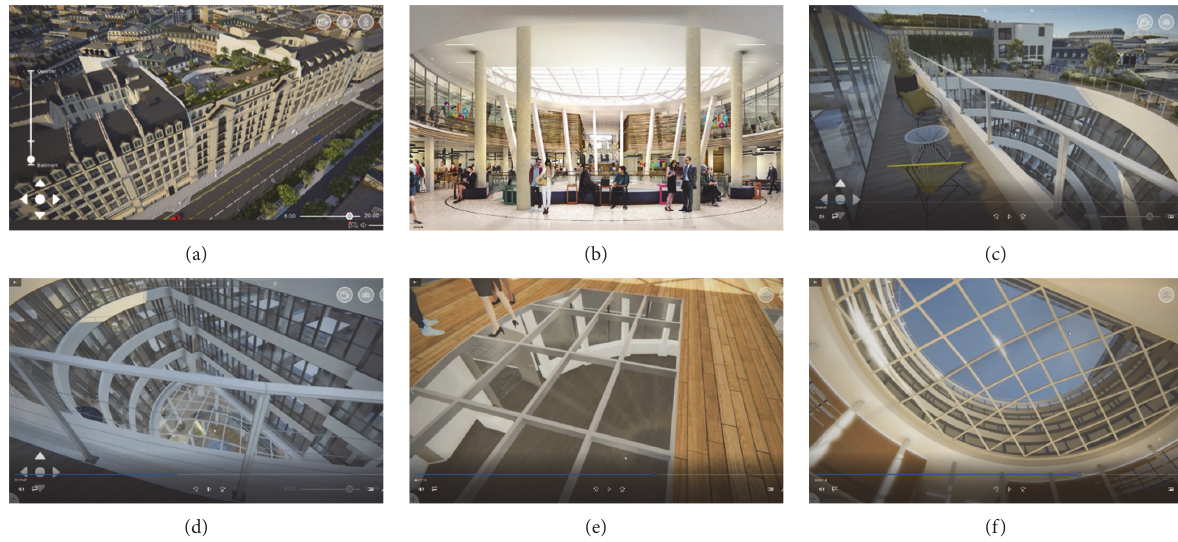
Figure 15: Selection of screenshot frames from the VR video clip (courtesy of © Generali Real Estate French Branch, adapted from http:// www.helloworldparis.com) inspired by the case-study palace in Paris, FR: (a) view of the building (from Rue R´eaumur); (b) internal open space; (c) top terrace; (d) glass conical envelope/facade; (e) glass floor (from the top/ground level); (f) glass roof (from the bottom/ground